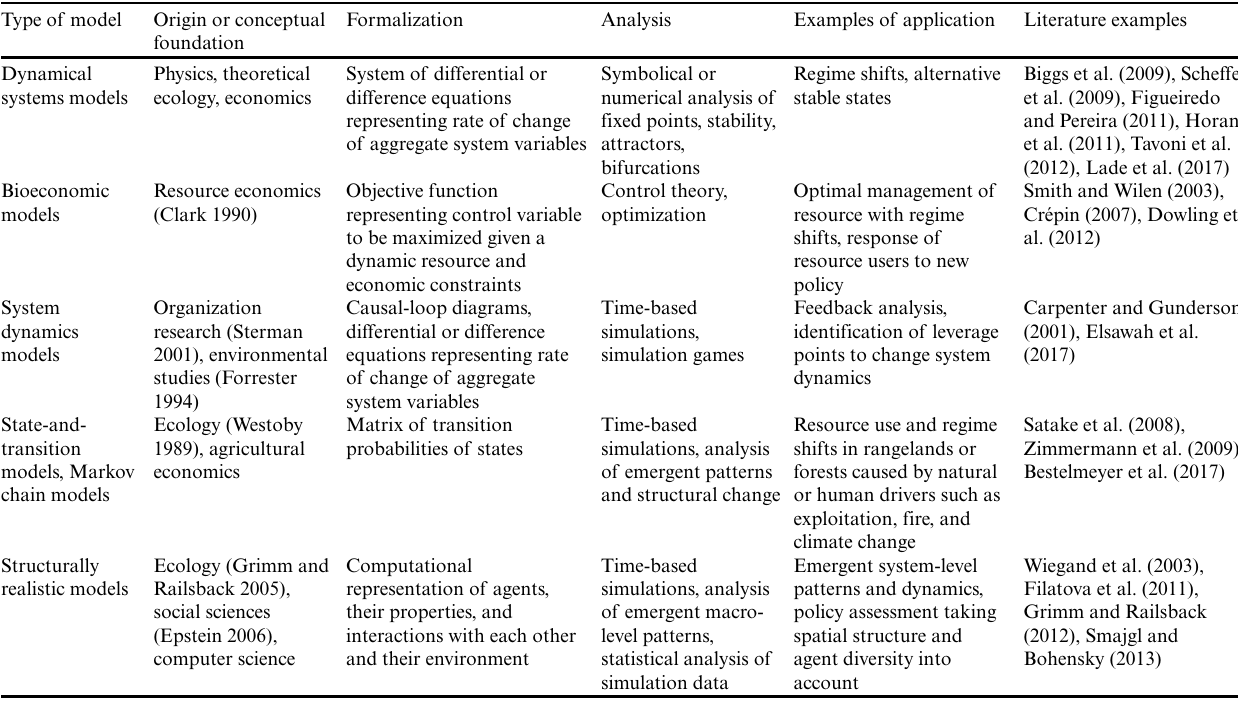
Table 2. Descriptions of model